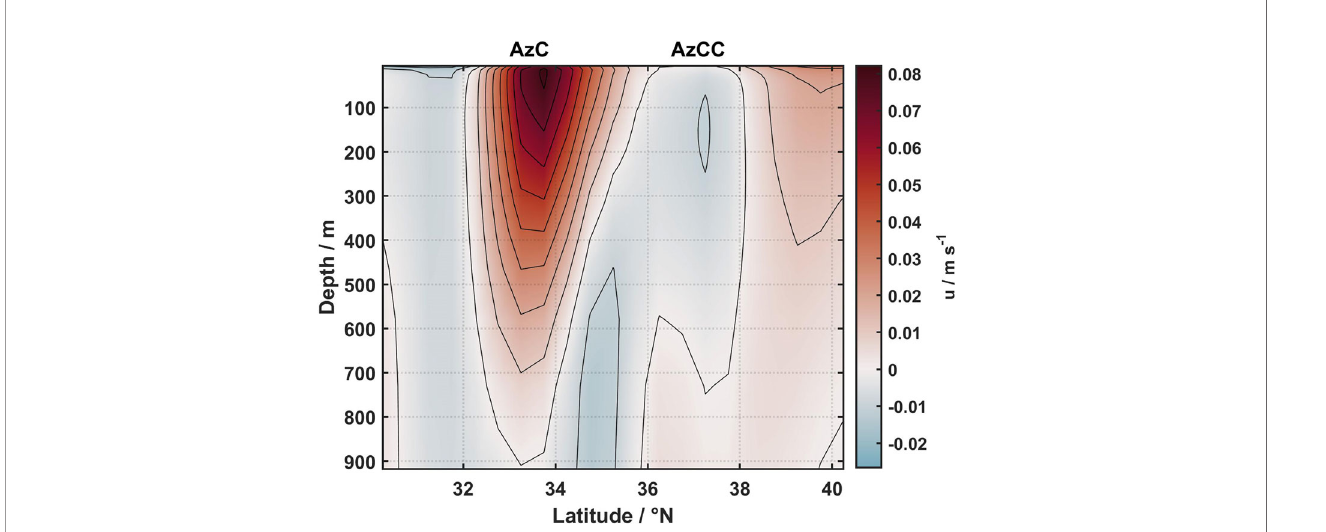
FIGURE 2 | The Azores Current System. Average of the zonal velocity component at the Azores Current region between 36°W and 20°W (see Figures 1B ) for the period 1871 and 2010. Positive values indicate eastward fl ow. The Azores Current (AzC) and Azores Countercurrent (AzCC; Onken, 1993) cores are identi fi